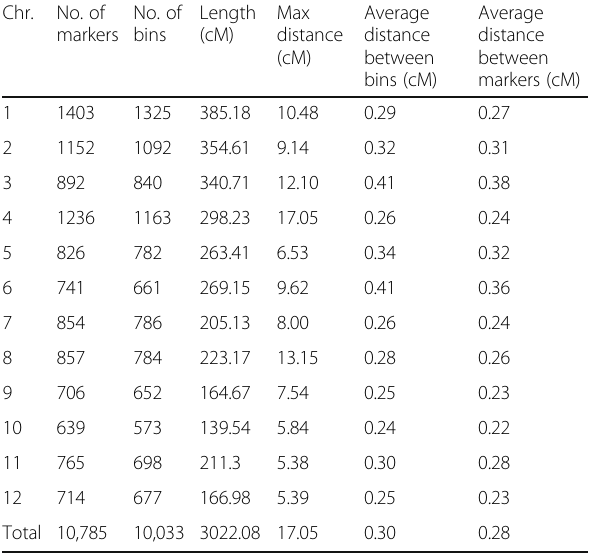
Table 2 Information on the integrated map from the three individual maps Chr. No. of No. of markers bins